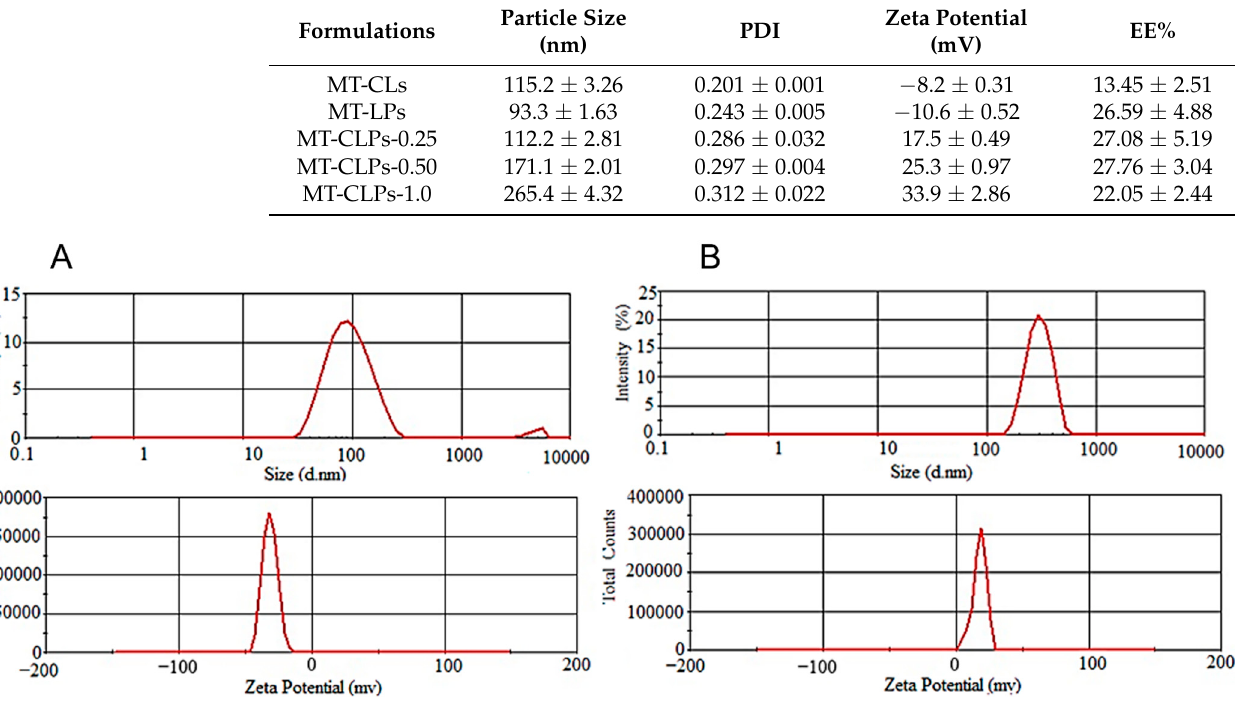
Figure 1. The particle size and zeta potential of MT-LPs ( A ) and MT-CLPs-0.5 ( B